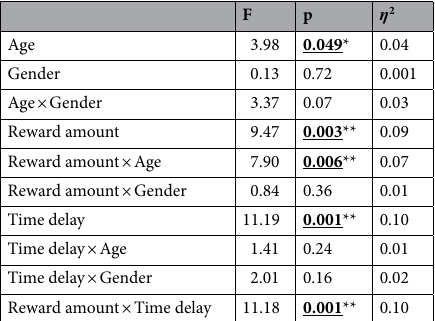
Table 3. Main and interaction effects in the ANOVA analyses for reaction time. *Significance ≤ 0.05; **Significance ≤ 0.01.